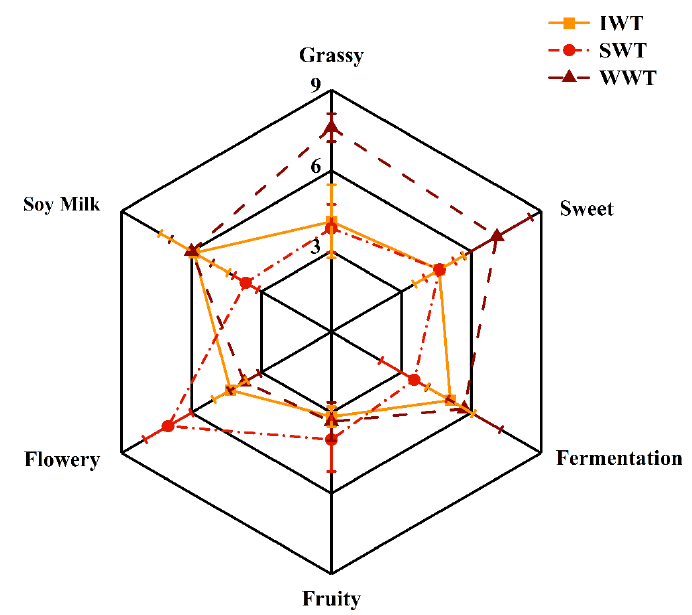
Figure 2. Radar plot for quantitative descriptive analysis (SWT: sunlight withering-treated white tea; WWT: withering-tank withering-treated white tea; IWT: indoor withering-treated white tea).